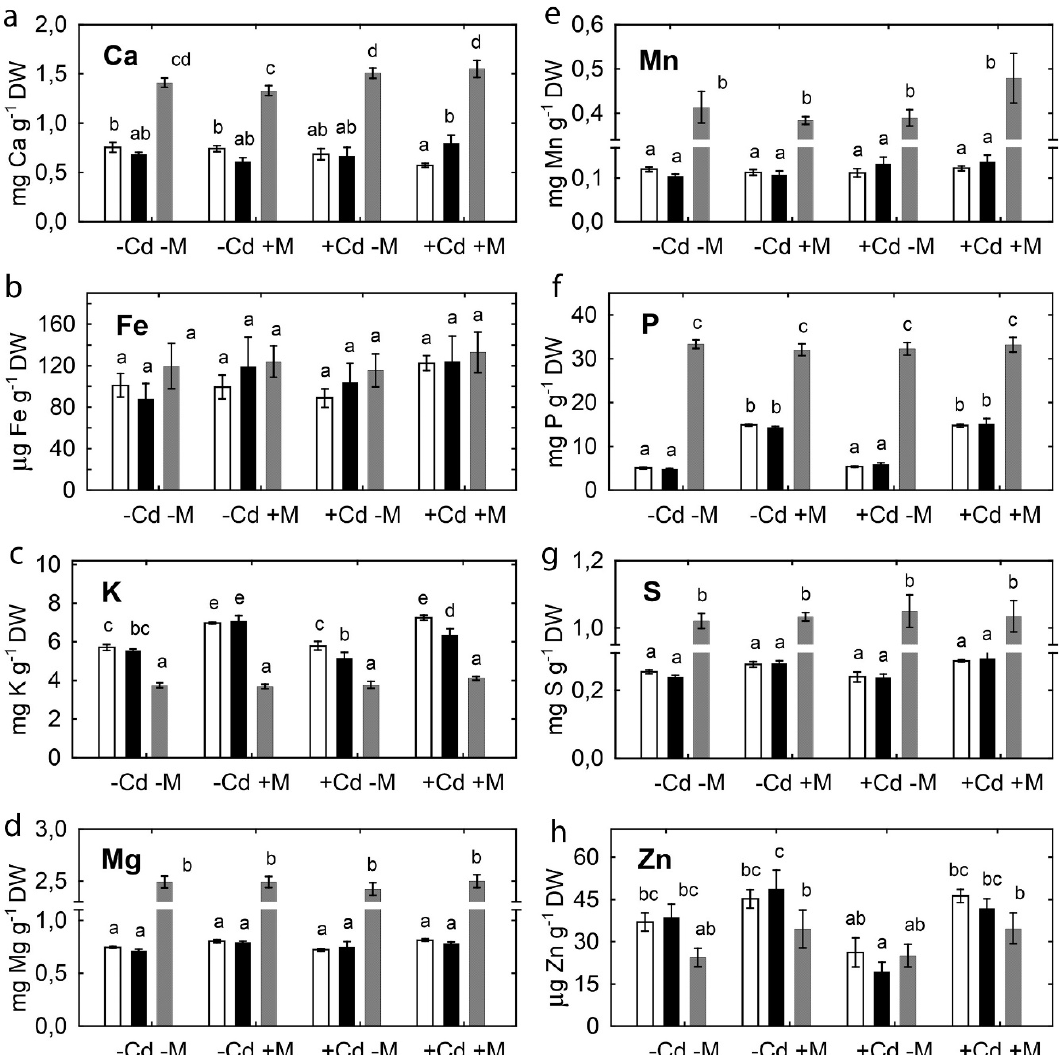
Figure 5. Calcium ( a ), iron ( b ), potassium ( c ), magnesium ( d ), manganese ( e ), phosphorus ( f ), sulfur ( g ), and zinc ( h ) in seeds of pea SGE (unfilled columns), SGECd t (filled columns), and B. juncea (gray columns) grown in uncontaminated or Cd-supplemented soil. Treatments: -Cd-M—uncontaminated soil with uninoculated plants, -Cd+M—uncontaminated soil with inoculated plants, +Cd-M—Cd-supplemented soil with uninoculated plants, +Cd+M—Cd-supplemented soil with inoculated plants. Plants were inoculated with a microbial consortium consisting of Variovorax paradoxus 5C-2, Rhizobium leguminosarum bv. viciae RCAM1066, and Glomus sp. 1Fo. Vertical bars show standard errors. Different letters show significant differences between treatments (least